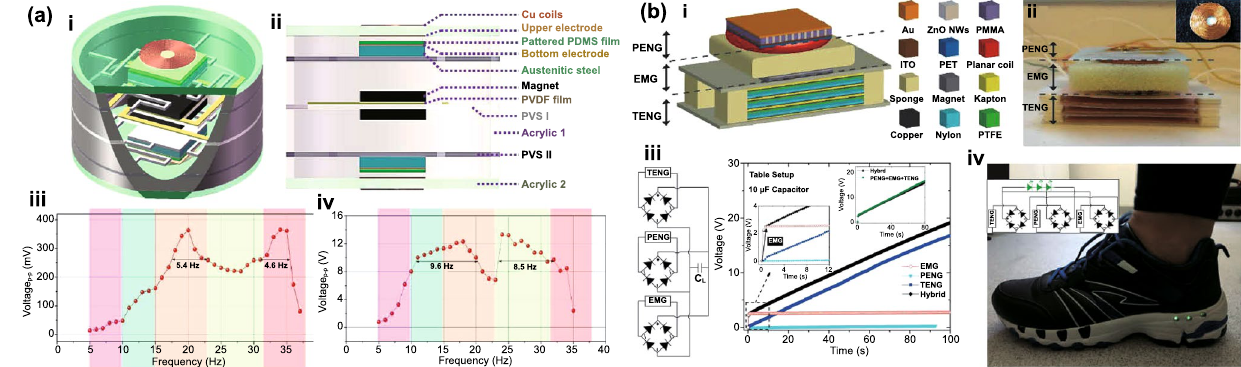
Fig. 19 a (i) Schematic and (ii) cross sectional view of the low-frequency piezoelectric-electromagnetic-triboelectric hybrid broadband vibra- tion energy harvester developed by He et al. Output peak-to-peak voltage as a function of the frequency under a 0.5 g acceleration for the (iii) EMG and (iv) TENG units. Reproduced with permission from Ref. [87]. Copyright 2017, Elsevier Ltd. All rights reserved. b (i) Schematic illus- tration and (ii) photograph of the stacked triboelectric-electromagnetic-piezoelectric hybrid nanogenerator for power-generating footwear devel- oped by Rodrigues et al. (iii) Circuit diagram of the energy harvesting system and charging curves of a 10 μF capacitor. (iv) Photograph of the hybrid generator placed within a shoe sole and lighting up green LEDs while walking. Reproduced with permission from Ref. [88]. Copyright 2019, Elsevier Ltd. All rights reserved. (Color figure